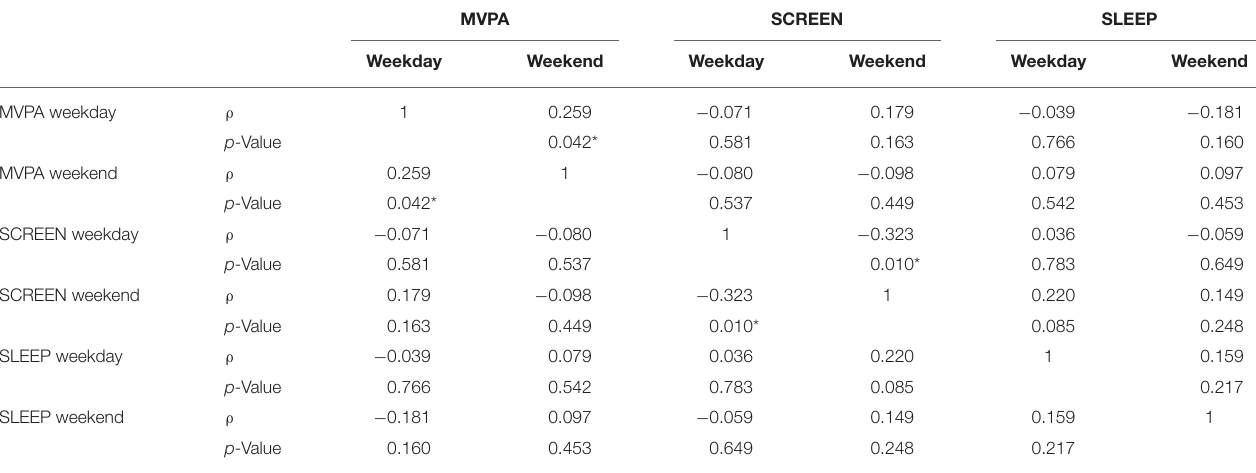
TABLE 3 | Bivariate correlations to difference scores (2018 no restriction minus 2020 lockdown values) in 24-HMB dependent variables, differentiated by weekday and weekend.